Question: In a single sentence, describe what this figure presents.
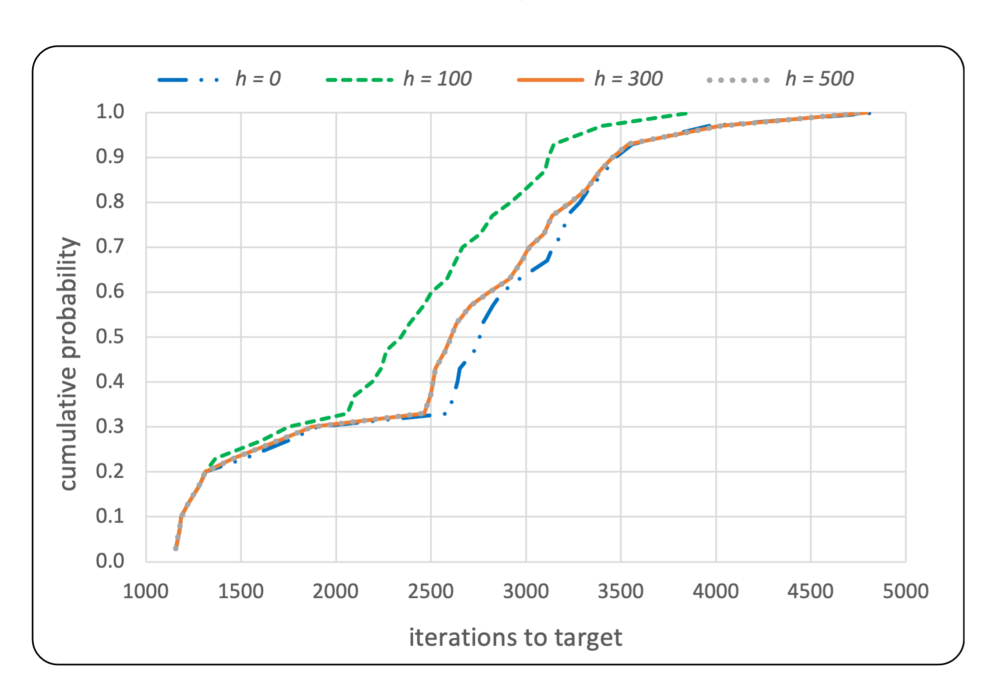
Answer: Run time distribution for analyzing of the restart parameter h: Large class